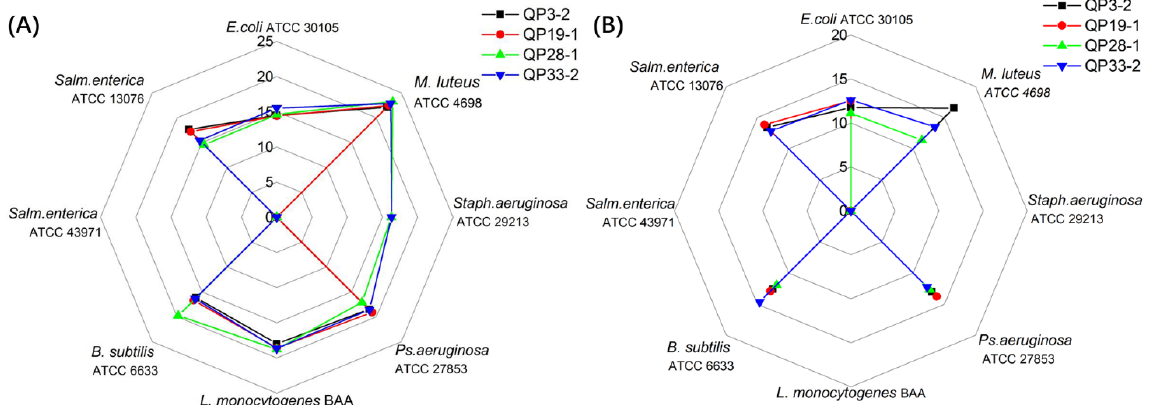
Figure 1. The influence of pH on antimicrobial activity. The value represents the diameter of the inhibition circle, containing the diameter of the Oxford cup (10.00 mm). ( A ) Antimicrobial activity of LAB strains at pH = 5; ( B ) antimicrobial activity of LAB strains at pH = 5.5. Table 2. The antibacterial activity of LAB strains after protease treatments.